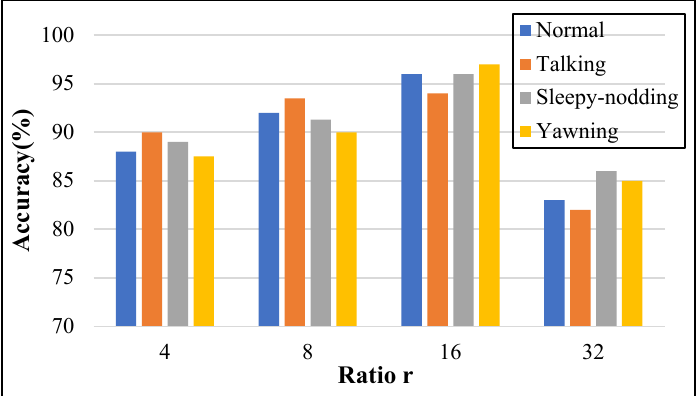
Figure 10. The detection accuracy of each behavior under different hyperparameter r